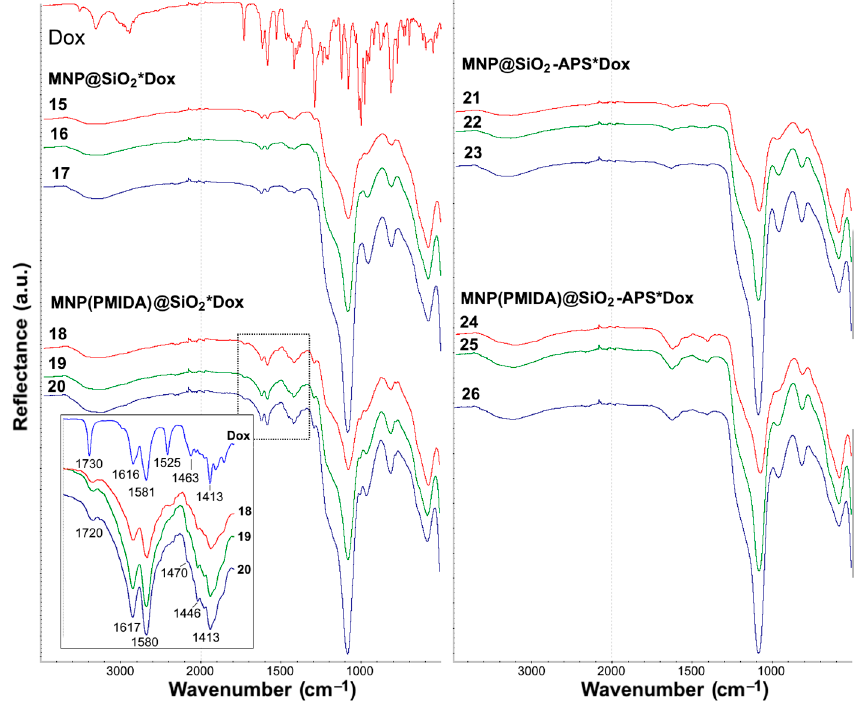
Figure 3. UATR-FTIR spectra of Dox-containing NCs 15 – 20 (left) and 21 – 26 (right); the inset shows an enlarged fragment of the spectrum in the region 1800–1350 cm − 1 .